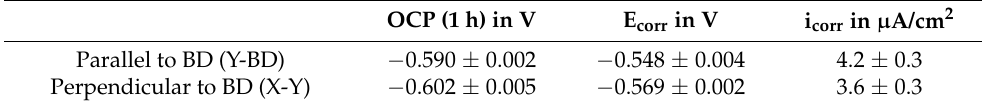
Table 4. Overview of values from potentiodynamic polarization measurements of the sample surfaces prepared parallel and perpendicular to the BD. The current density (i corr ) values of the perpendicular to BD samples are in accordance to a former study [33]. OCP: Open circuit